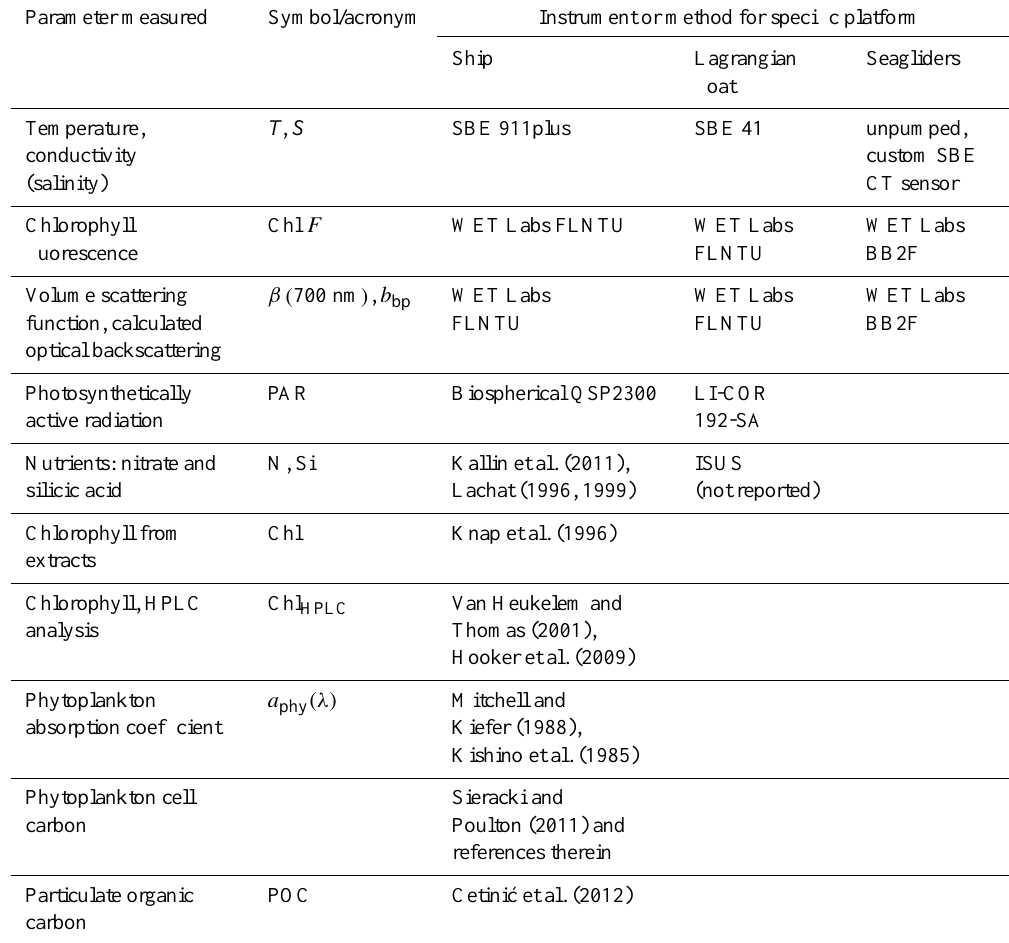
Table 1. List of measured variables and methodologies, as measured on different platforms. Parameter measured Symbol/acronym Instrument or method for specific platform Ship Lagrangian float